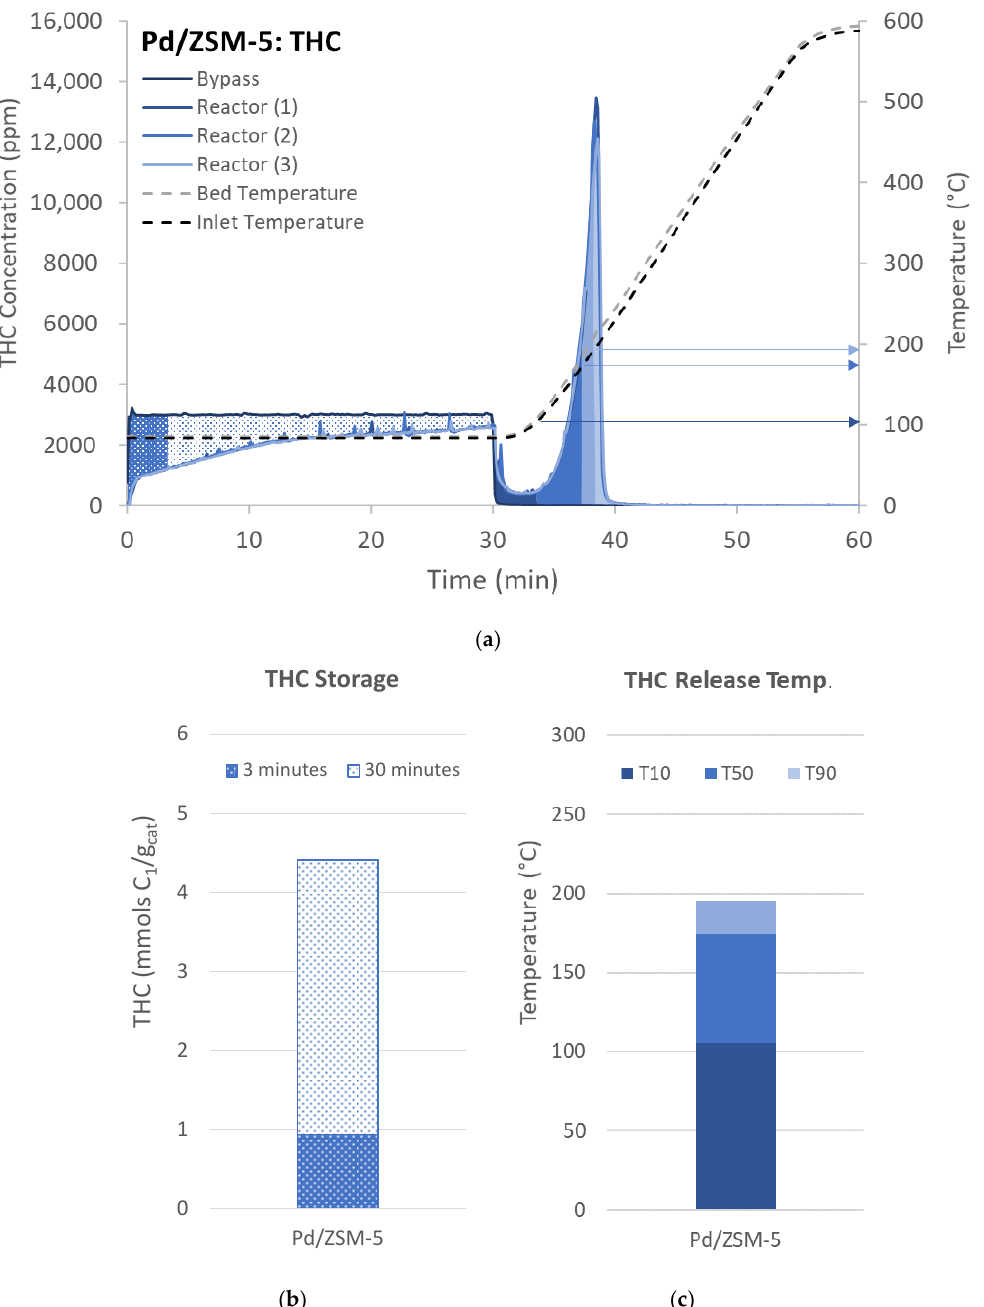
Figure 2. ( a ) THC concentration for each of the three reactor evaluations throughout the 60 min experiment. The shading represents 3 ( ) and 30 ( ) minutes of adsorption during uptake and the zones/temperatures associated with 10% (T10, ■ ), 50% (T50, ■ ), or 90% (T90, ■ ) of THC released during desorption, which are also indicated with arrows. These characteristics are then represented by bar charts for both ( b ) adsorption and ( c ) desorption.